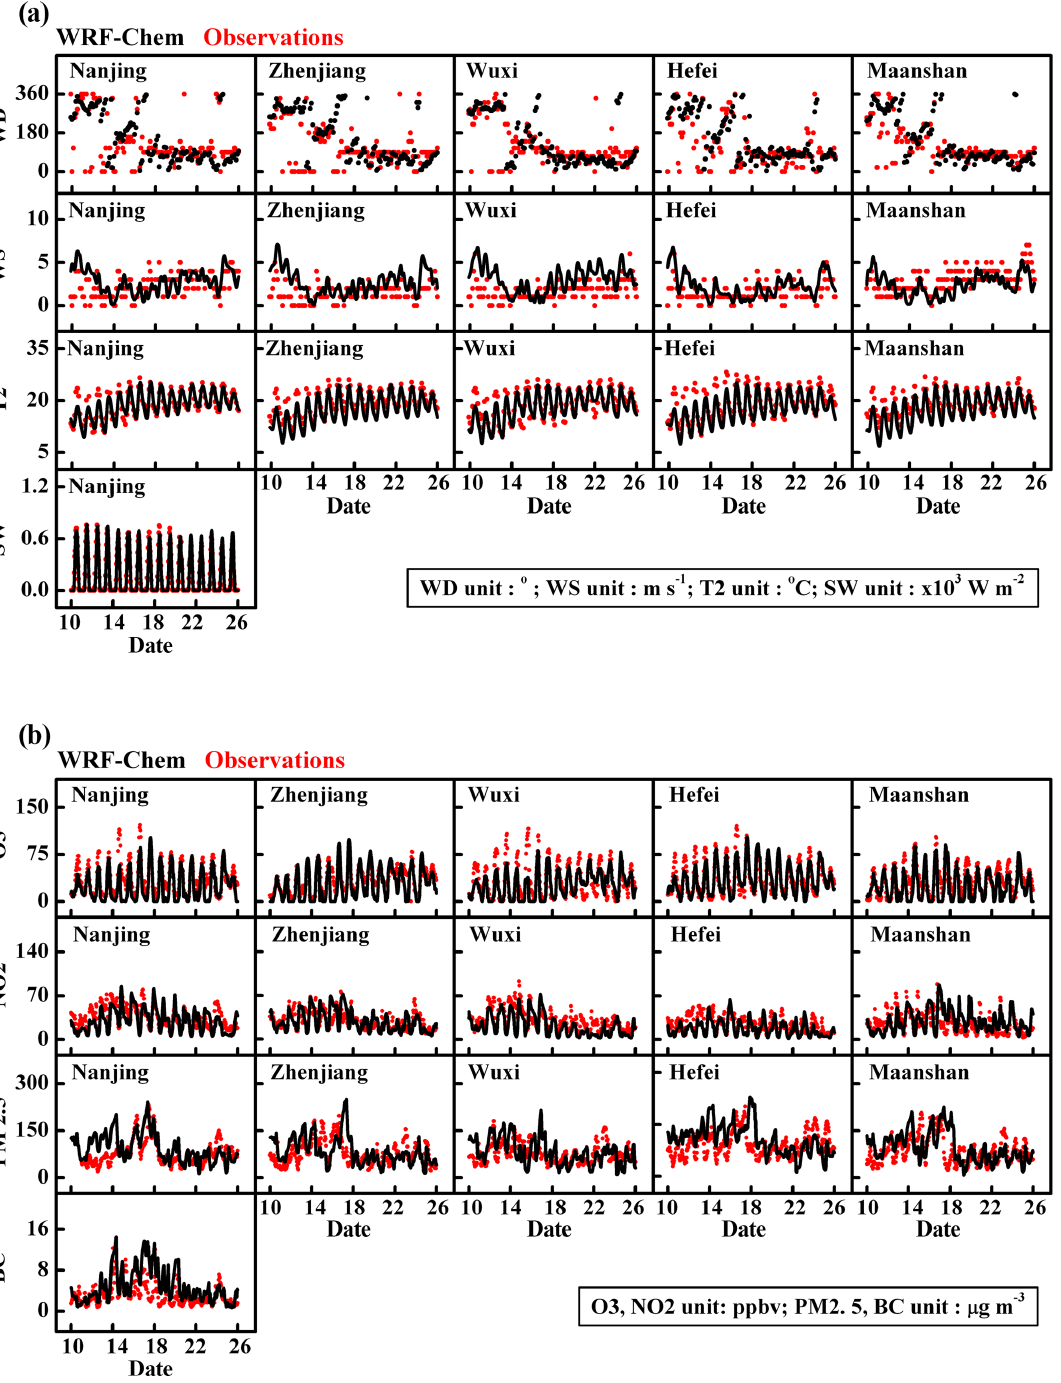
Figure 2. (a) Time series comparisons of meteorological variables between observations and simulations from 10 to 26 October 2015. (WD is wind direction; WS is wind speed; T2 is temperature at 2m above the surface; and SW is shortwave). (b) Same as Fig. 2a but for chemical variables (O 3 is ozone; NO 2 is nitrogen dioxide; PM 2 . 5 is particulate matter with diameter less than or equal to 2.5µm; and BC is black